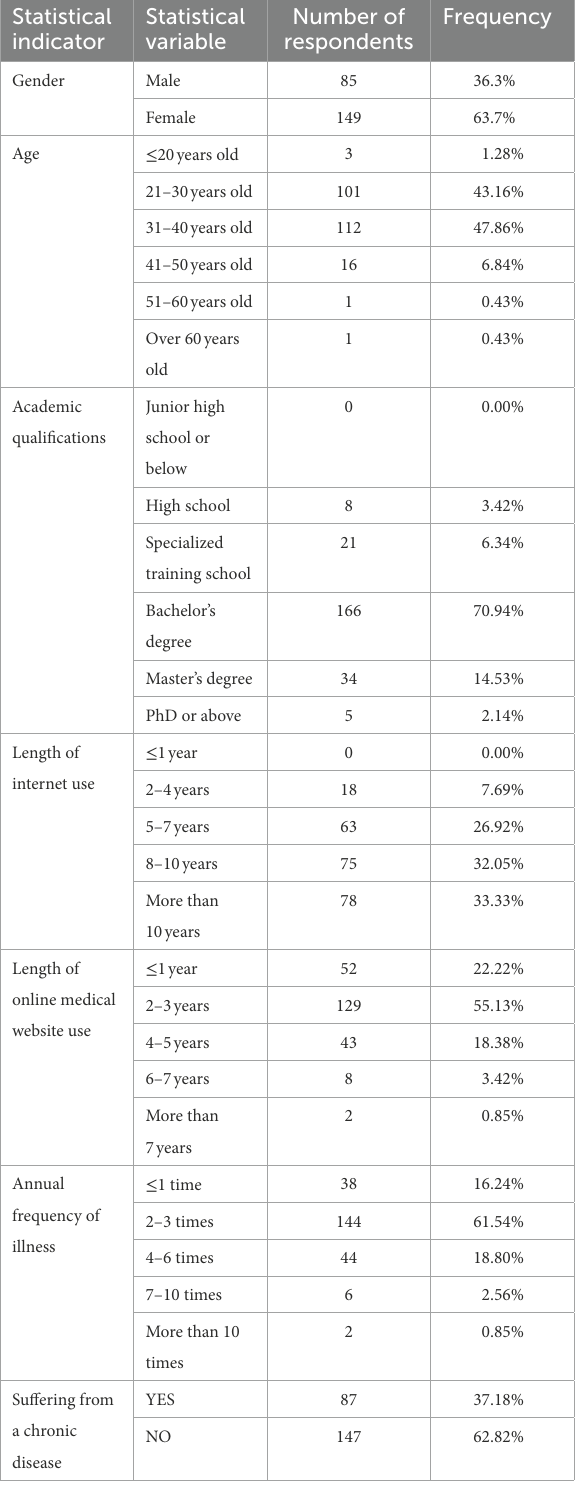
TABLE 3 Descriptive statistics of the